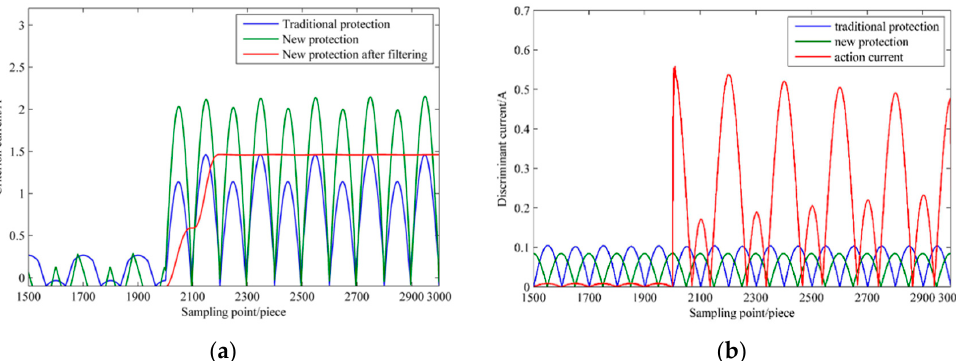
Figure 5. High-resistance grounding fault at 50% of phase B. ( a ) Sum of fault component current. ( b ) The voltage difference of the fault component.